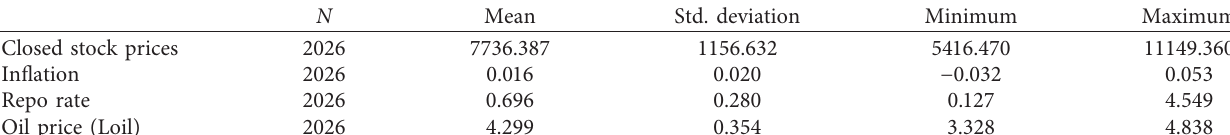
Table 1: Descriptive statistics of the dataset in Saudi stock market.